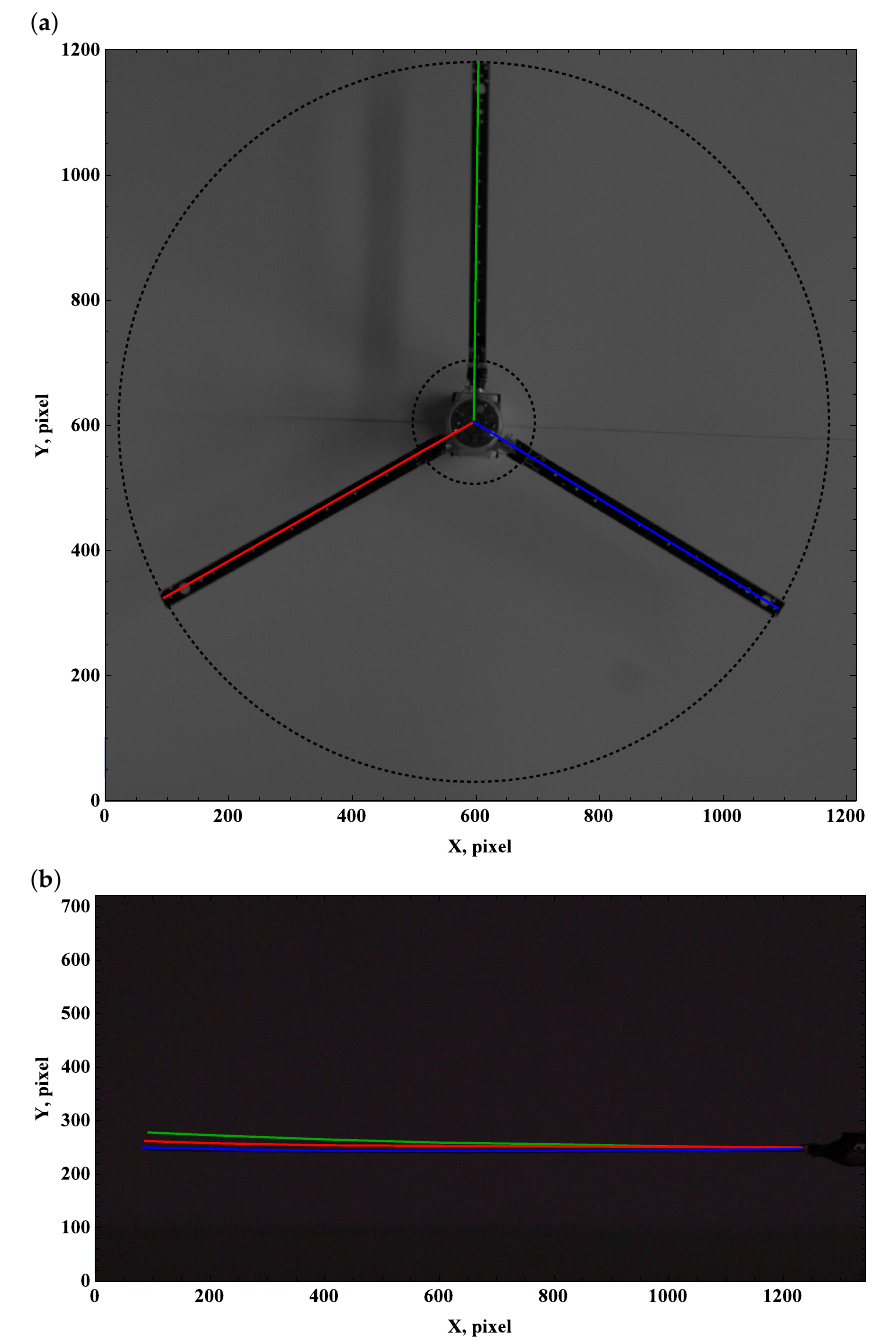
Figure 7. Preset angle 5 ◦ , angular speed 100 rpm: top view ( a ), side view ( b